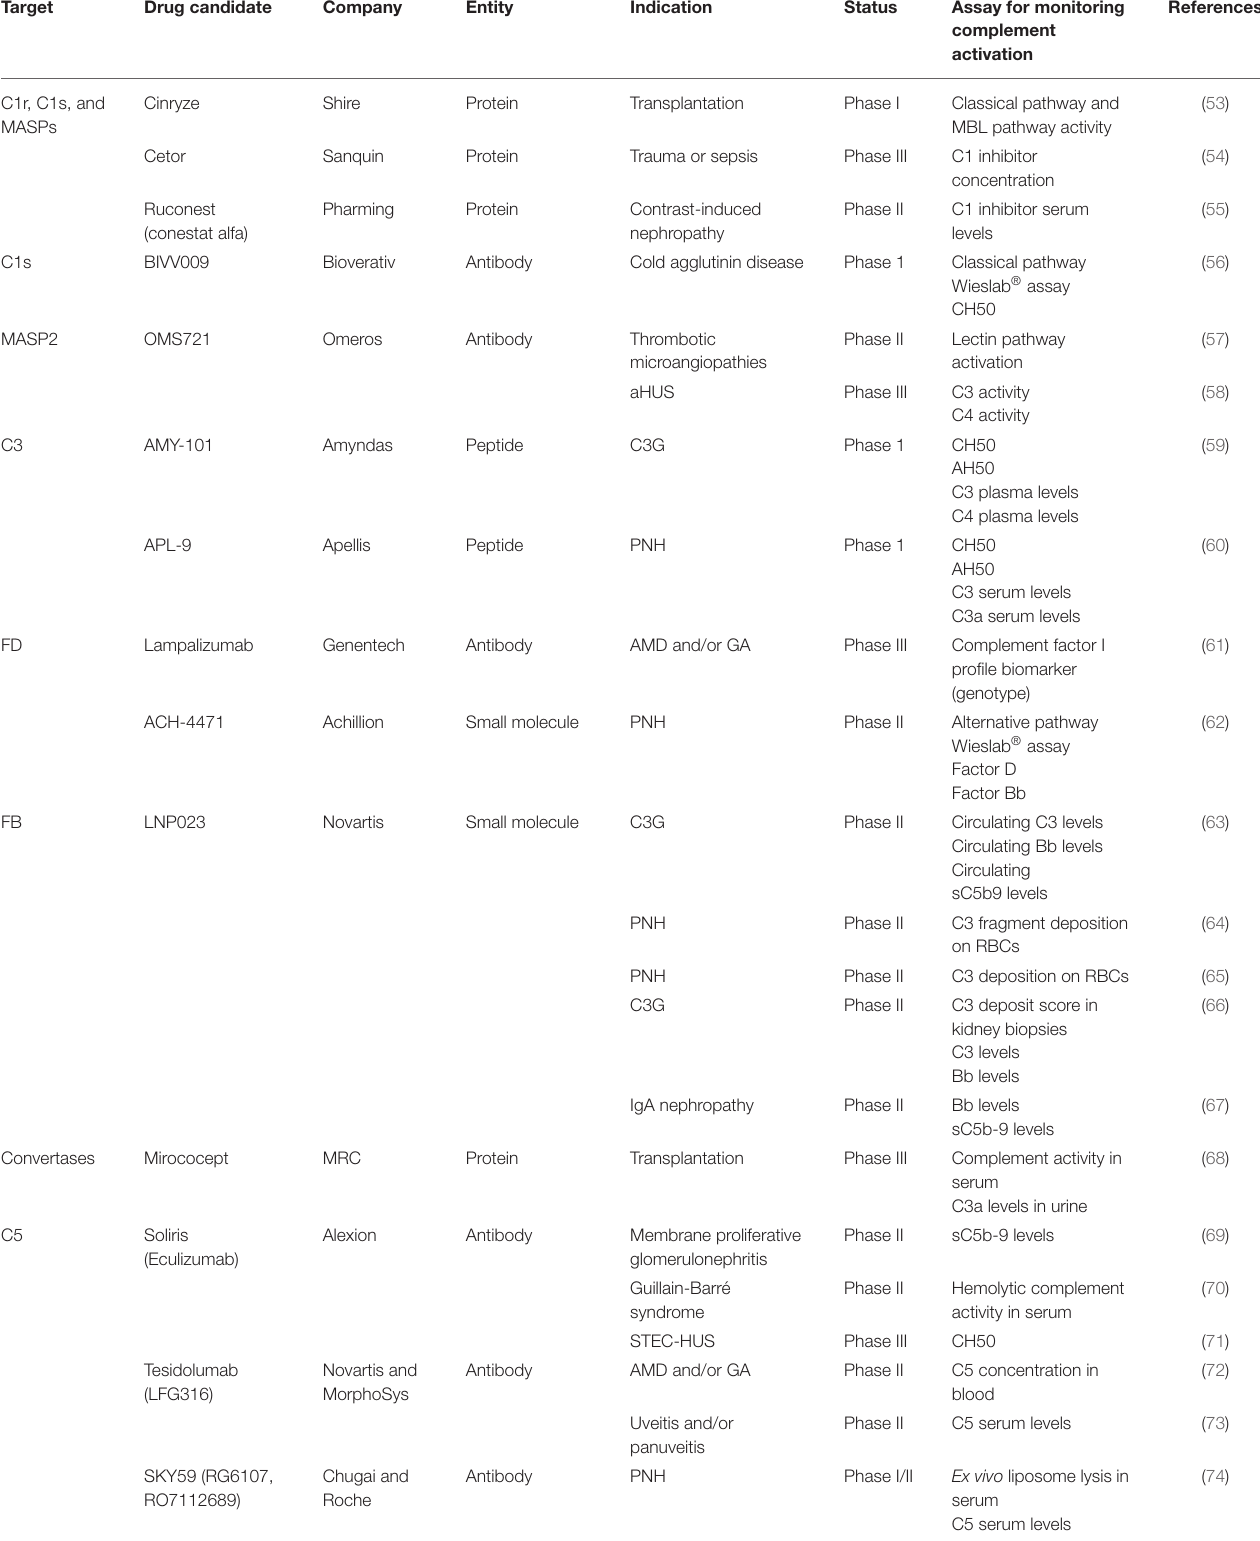
TABLE 3 | Monitoring of complement activity in clinical trials of complement therapeutics.